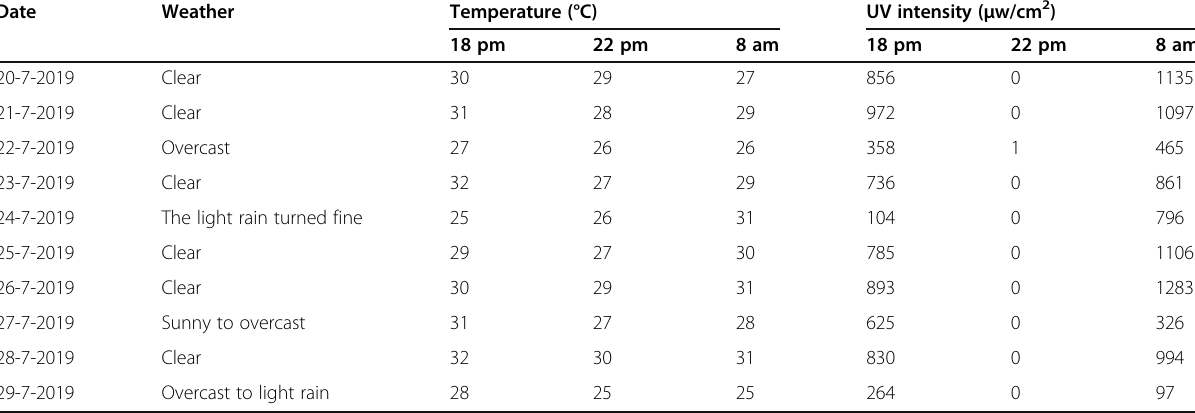
Table 1 Daily weather conditions in the field exposure